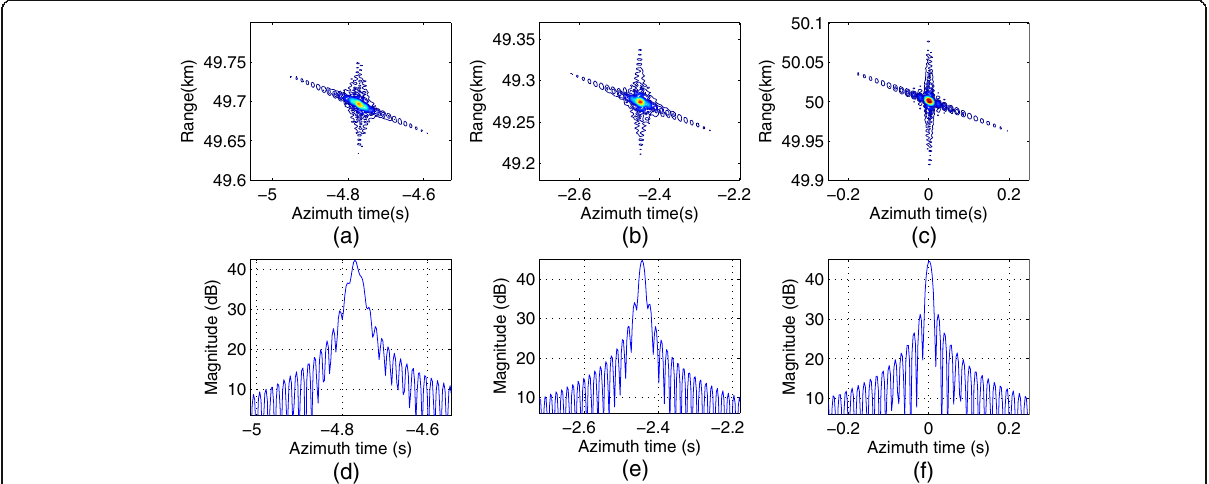
Fig. 14 Results by the proposed algorithm in case I. a Focused image of T 2 . b Focused image of T 1 . c Focused image of T 0 . d Azimuth profile of T T T 2 . e Azimuth profile of 1 . f Azimuth profile of